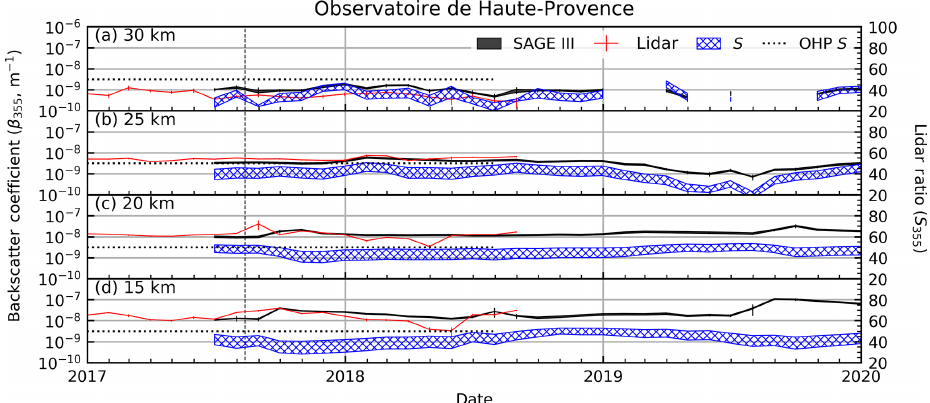
Figure 10. Same as Fig. 7, but for SAGE III. Vertical dashed line indicates the 2017 pyroCB event.